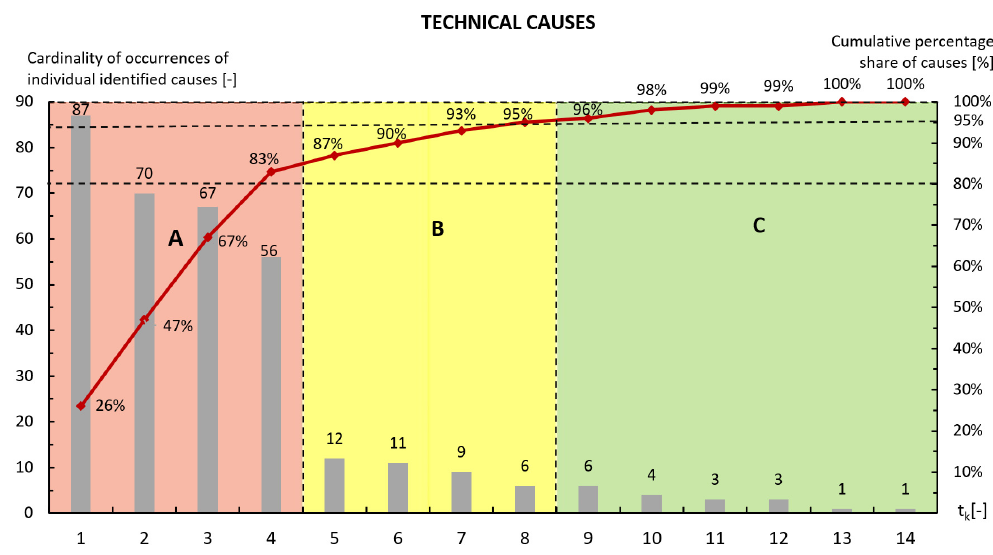
Figure 2. Pareto-Lorenz chart of the identified technical causes.